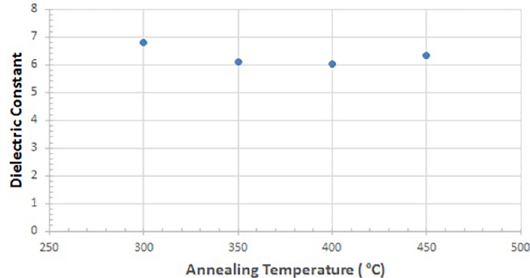
with different annealing 3